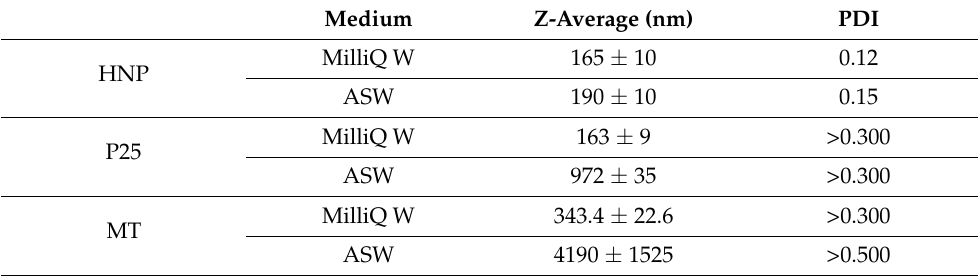
Figure 1. Images obtained by transmission electron microscopy (TEM) of NPs suspended at room temperature (23 °C) through sonication. ( A ) CB-derived hydrophilic NPs (HNP, 50 µ g/mL) in distilled water showing aciniform aggregates of almost spherical primary particles; ( B ) Aeroxide ® TiO 2 P25 (P25, 10 µ g/mL) in ASW showing large aggregates; ( C ) mesoporous titania (MT, 10 µ g/mL) in ASW showing large NPs aggregates. Table 1. Physicochemical characterization by DLS analysis of MT (10 µ g mL − 1 ) and P25 (10 µ g mL − 1 ) and HNP in ultrapure water (MilliQ W), ASW at room temperature (23 ◦ C), showing the size-related parameters of NPs, such as Z-Average (nm) and Polydispersity Index (PDI,